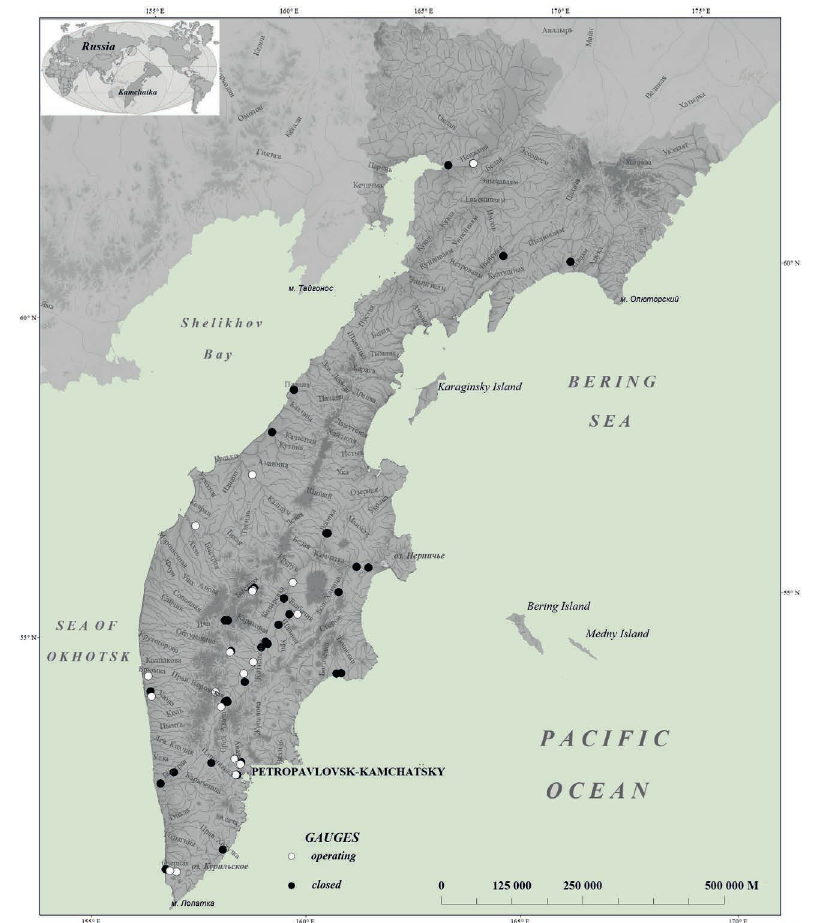
Fig. 1 Gauges with SSF characteristic measurements in the Kamchatka